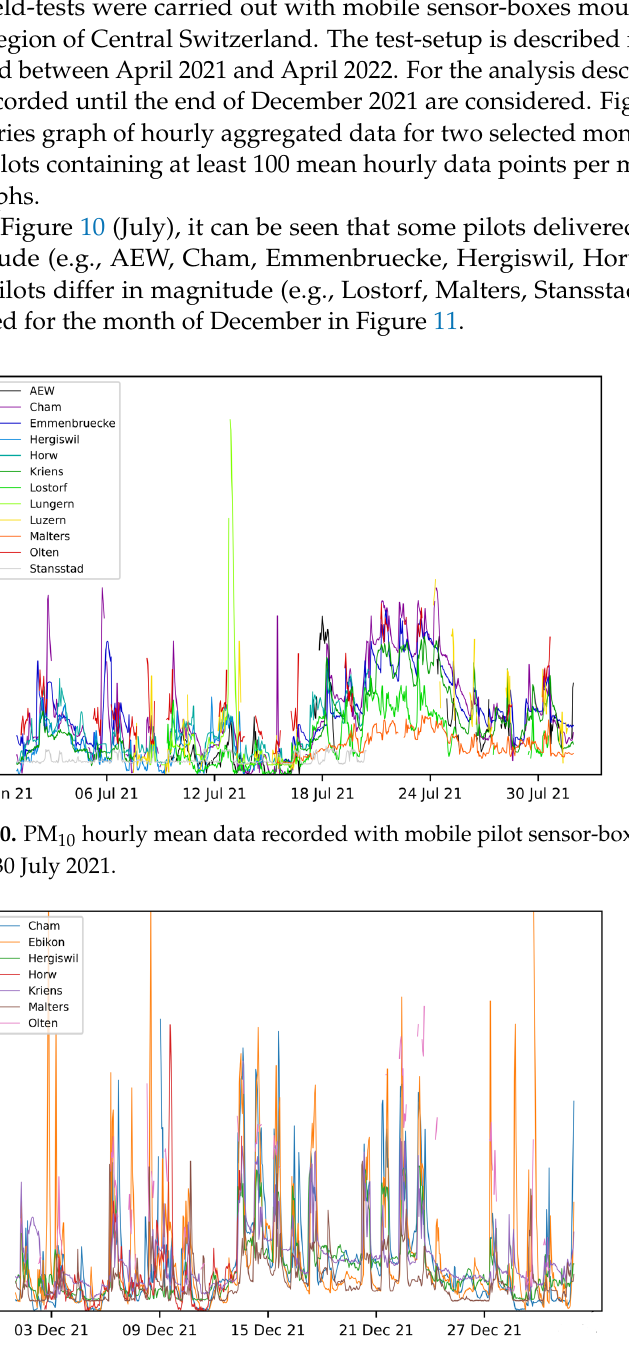
Figure 11. PM 10 hourly mean data recorded with mobile pilot sensor-boxes in the period from